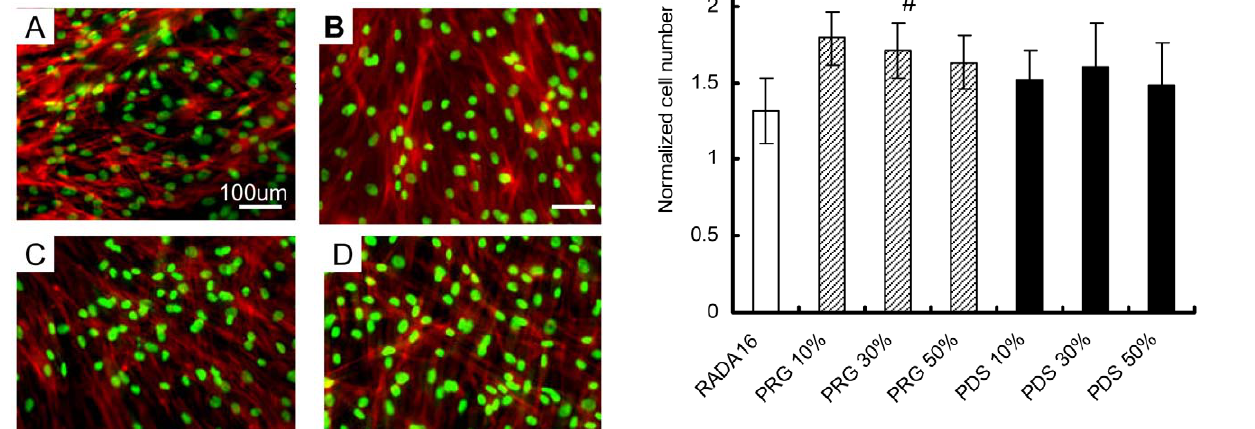
Figure 3. Cell densities on the different scaffolds of different mix ratio of designer PRG/PDS and pure RADA16 after two weeks culture. Initial seeding density (255 cells/mm 2 ) was used to calculate fold changes in cell densities after two weeks in culture for each of thescaffolds. Thereisa tendency of periodontalligament fibroblasts to proliferate on functionalized peptide scaffolds PRG and PDS. The fibroblasts proliferated significantly on PRG 10% and 30% compared to RADA16 ( # r , 0.01 vs RADA16). PRG/PDS concentration in the mix as low as 10–30% seems to be effective for growing the fibroblasts.